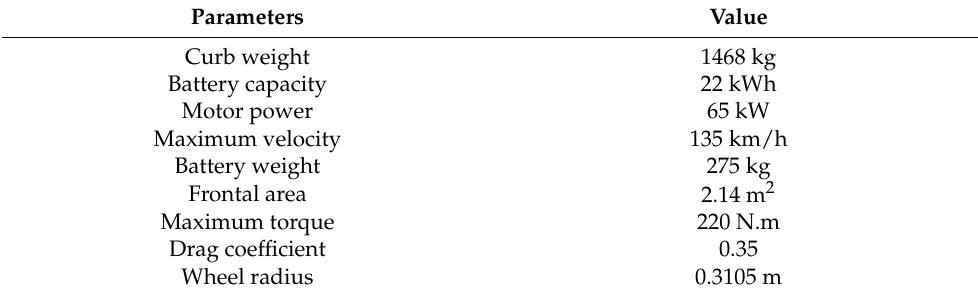
Table 1. Electric vehicle